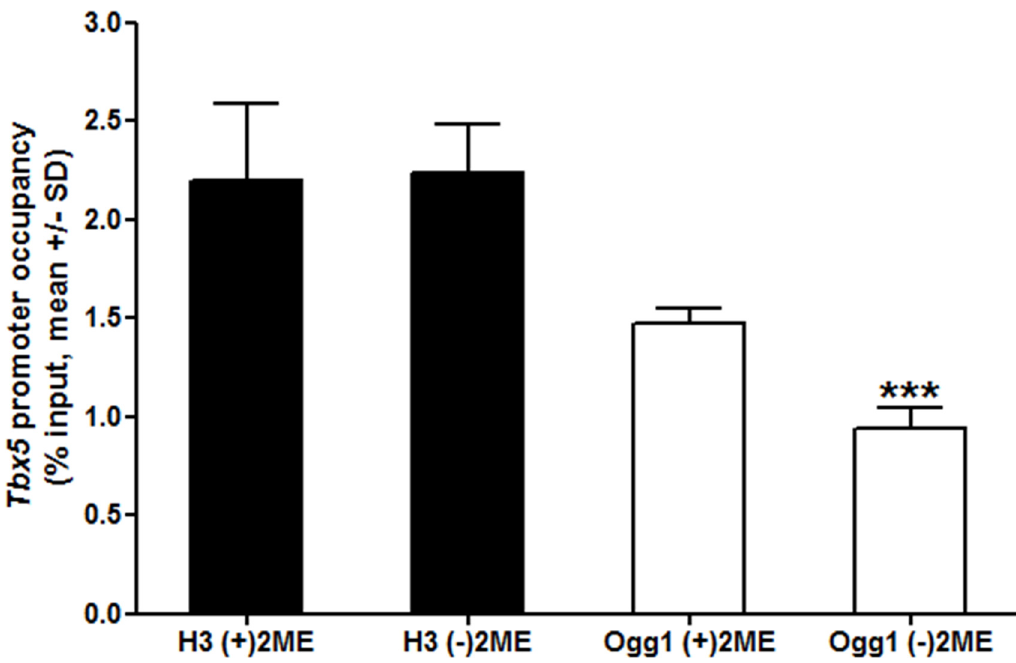
Fig 3. Occupancy of Ogg1 at the Tbx5 promoter. ChIP-qPCR results showed specific reduced occupancy by Ogg1 (white bars) at the Tbx5 promoter in oxidative stressed R1 mouse ESCs while occupancy by histone H3 did not change. Mean ± standard deviation (SD), *** p < 0.001, one-sided t-test.